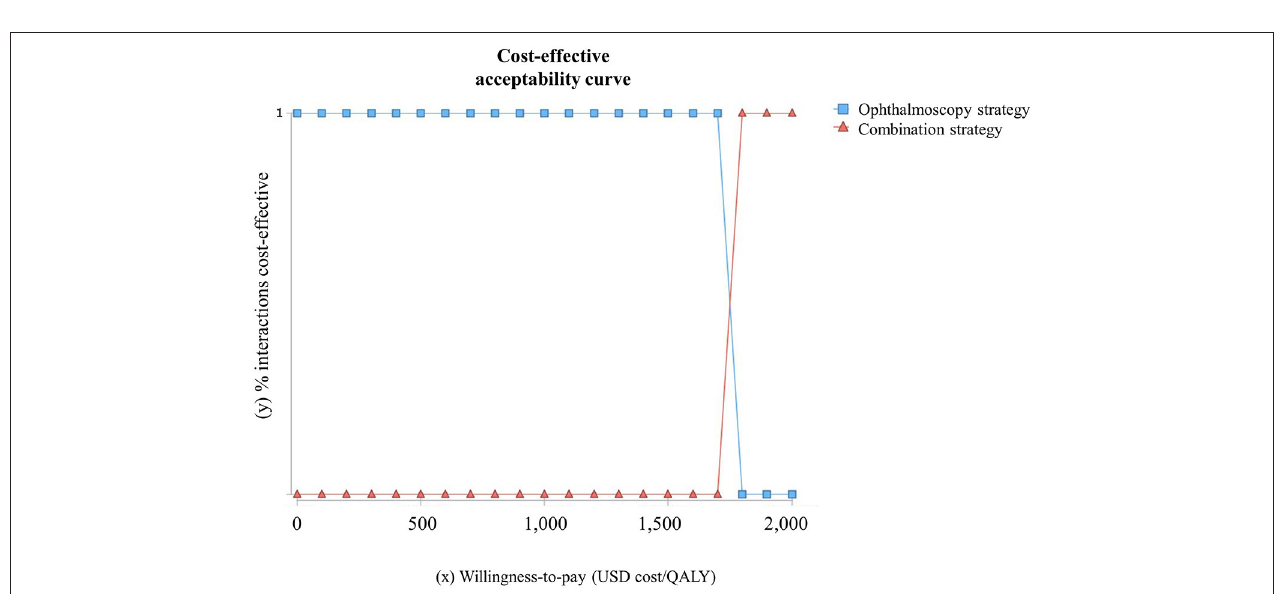
FIGURE 3 | Monte Carlo probabilistic cost-effective acceptability curve. Interactions cost-effective percentages ( y ) between combination strategy (blue square) and ophthalmoscopy strategy (red triangle) by willingness-to-pay (WTP) ( x ) ranging from 0 to USD 2,000/QALY. Above USD 1,800/QALY combination strategy is 100%